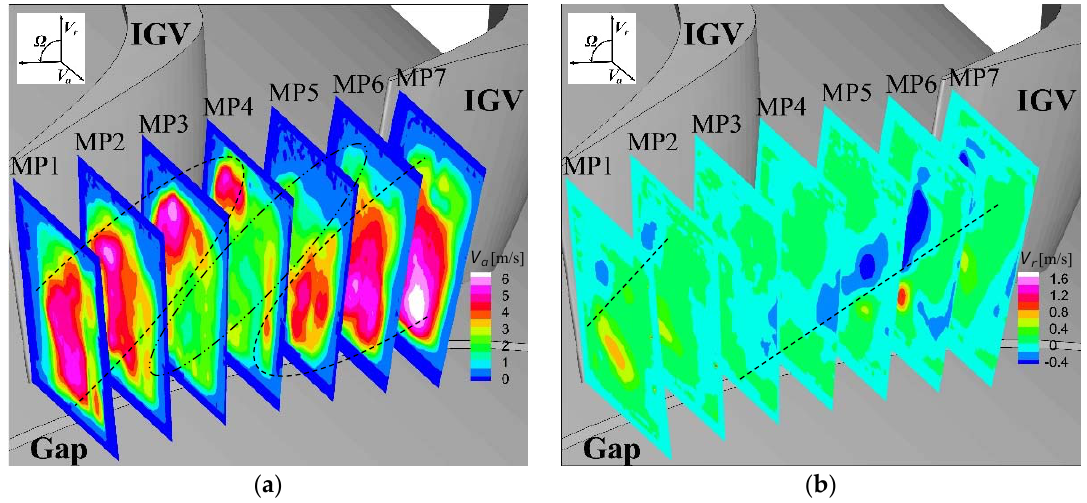
Figure 4. Time ‐ averaged flow structure of the inter ‐ stage flow in Case 1. ( a ) (cid:1848) (cid:3028) ; ( b ) (cid:1848) (cid:3045) . Figure 4. Time-averaged flow structure of the inter-stage flow in Case 1. ( a ) V a ; ( b ) V r